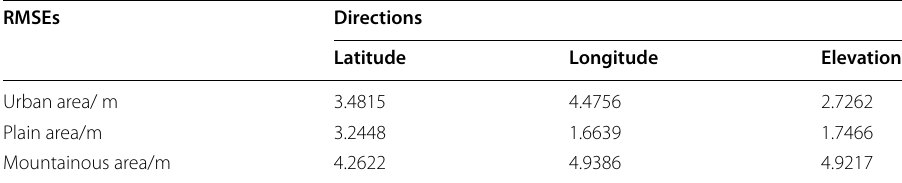
Table 4 Results of the absolute positioning accuracy for the Hongqi-1-H9 wide-range satellite under different terrains